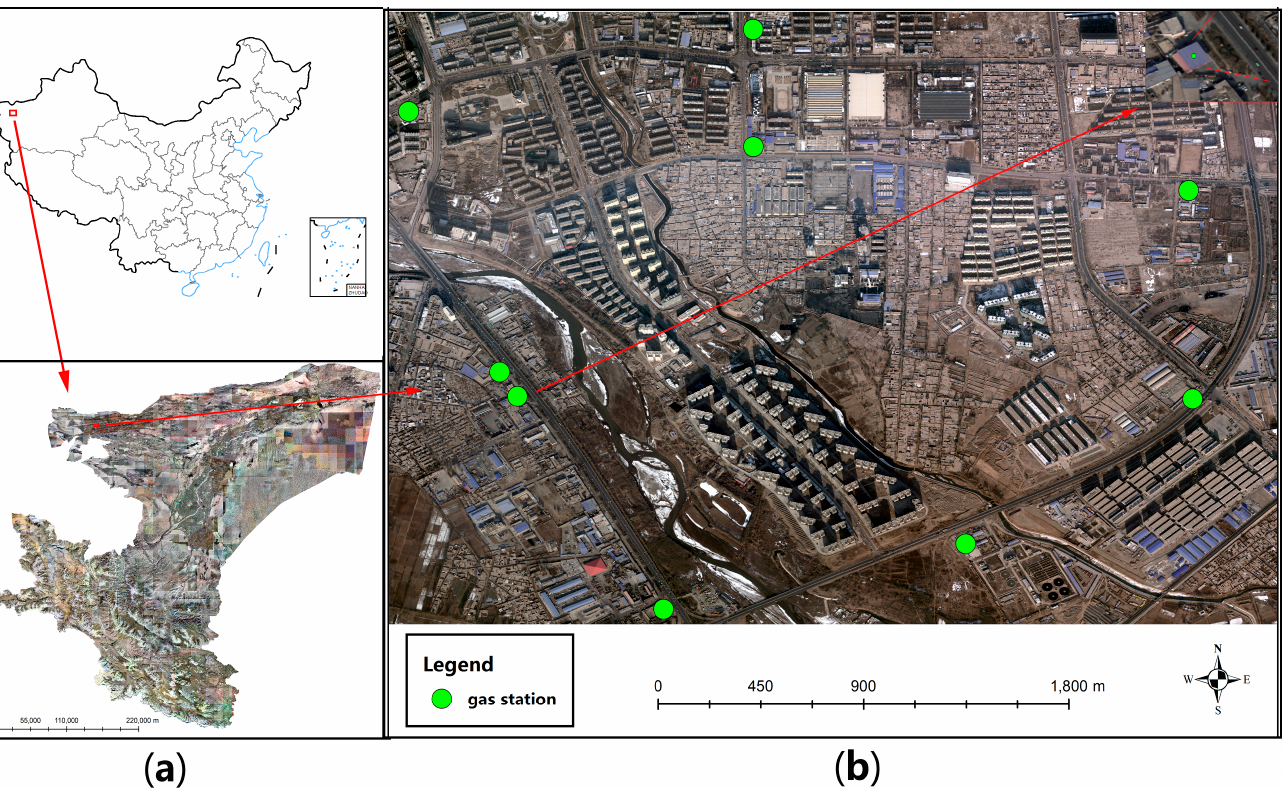
Figure 1. Part of the remote sensing images and POI data used in the creation of the gas station (GS) dataset: ( a ) thumbnail of remote sensing images of Kashgar area provided by the funded project and ( b ) a small piece of POI data samples used to assist the production of the GS